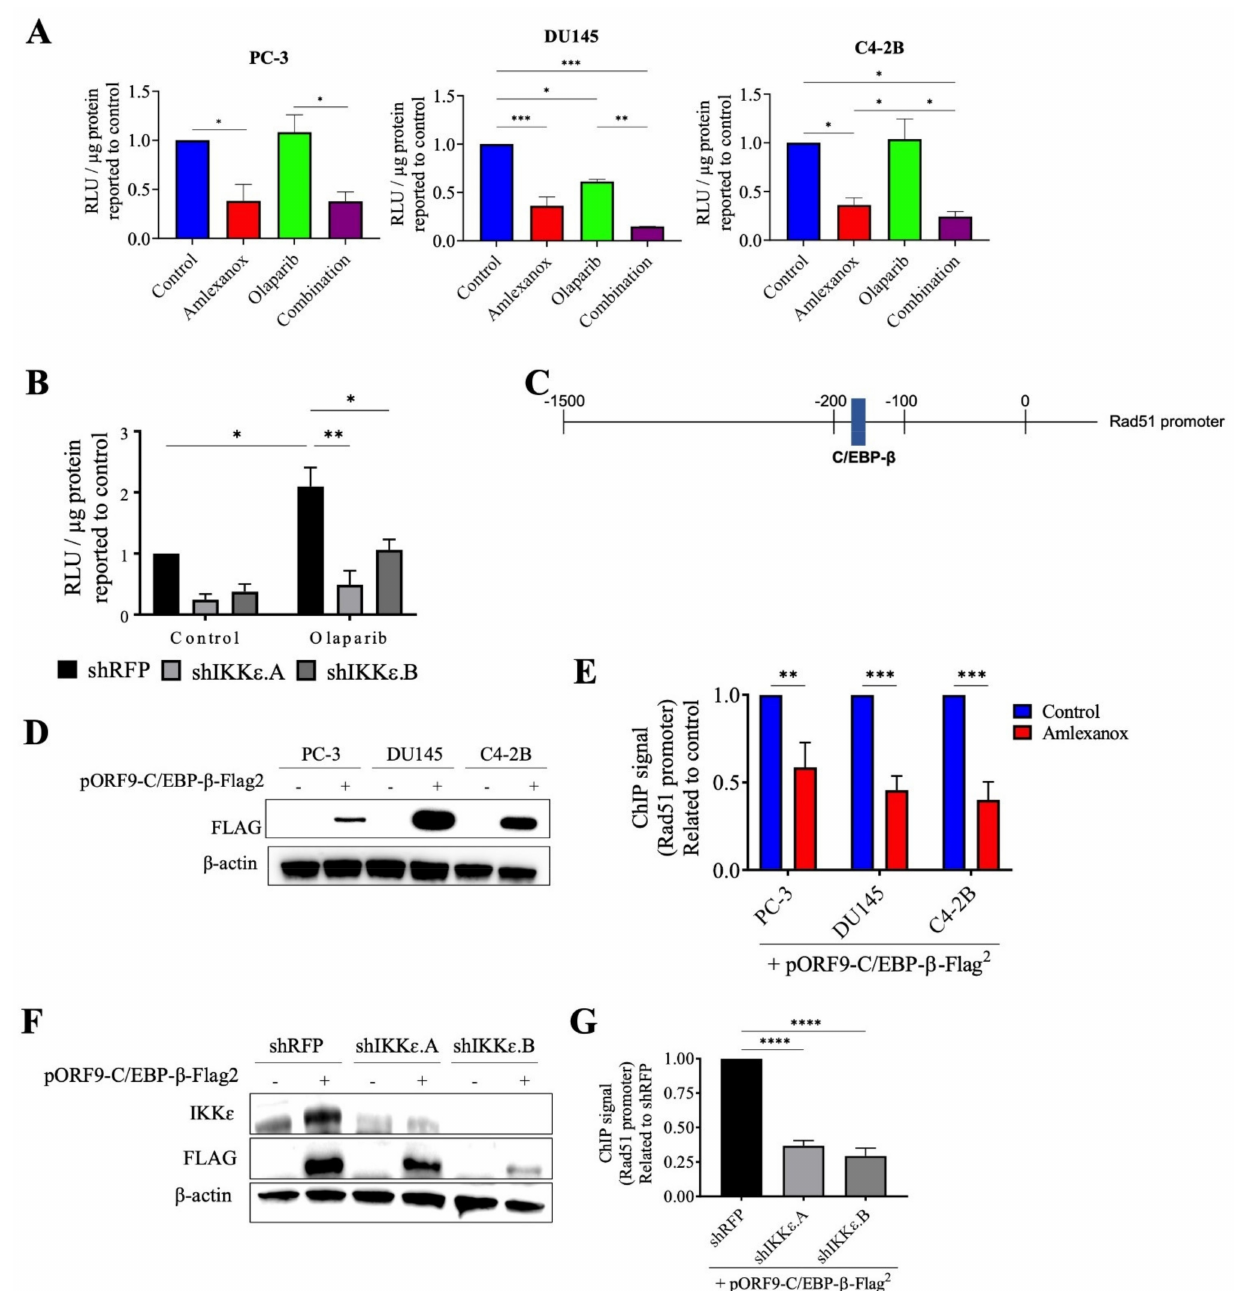
Figure 5. Amlexanox decreases Rad51 transcription by inhibiting C/EBP- β activation. ( A , B )